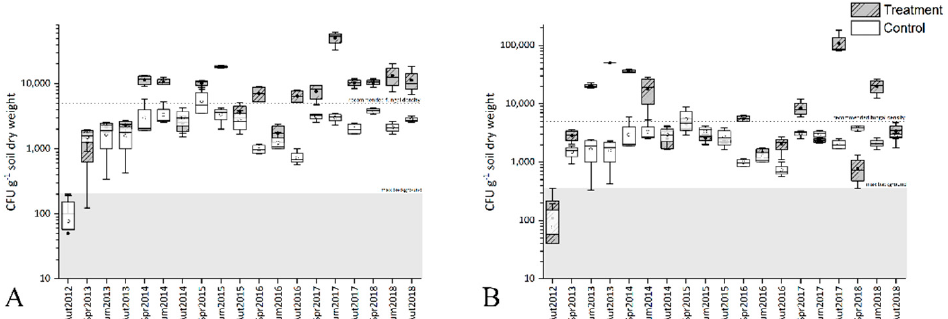
Figure 1. Metarhizium spp. abundance in GranMet-P TM applied Styrian field sites. ( A ) shows soil samples taken from field site Styria 2, ( B ) Styria 1, both compared to untreated control site. Samples were taken in spring (Spr), summer (Sum), and autumn (Aut) from autumn 2012 to autumn 2018. The grey box indicates maximal background CFU levels before treatment, the dotted lines show recommended fungal density for sustainable control in the soil [1]. Lines and dots in box plots show median and mean CFU g − 1 soil dry weight, respectively; boxes show the 25th and 75th percentiles, whiskers the 10th and 90th percentiles.